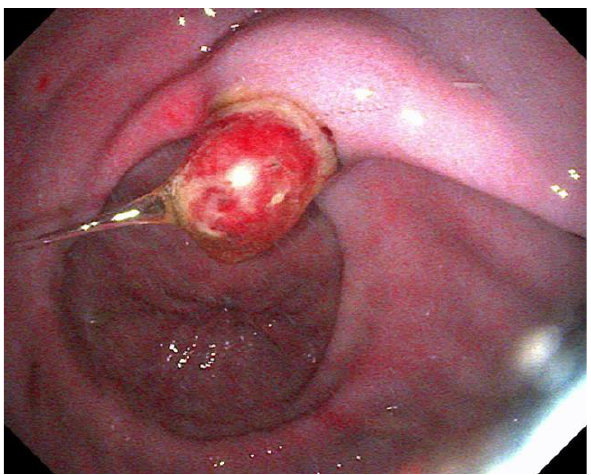
Figure 1. An adenomatous polyp in the pyloric region.